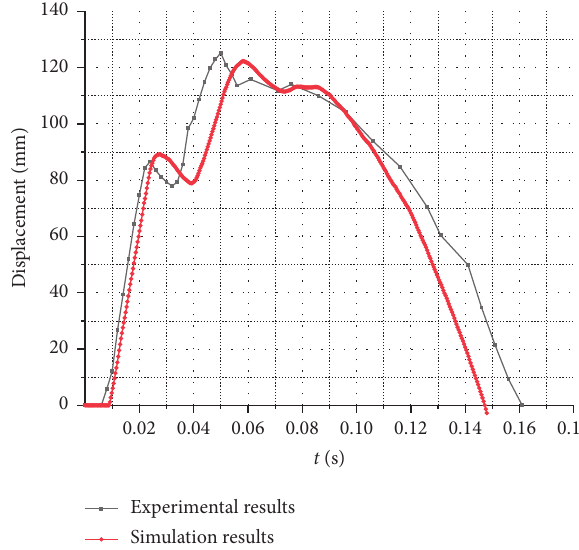
Figure 18: Comparison of the displacement-time history curves of the 18th coil.